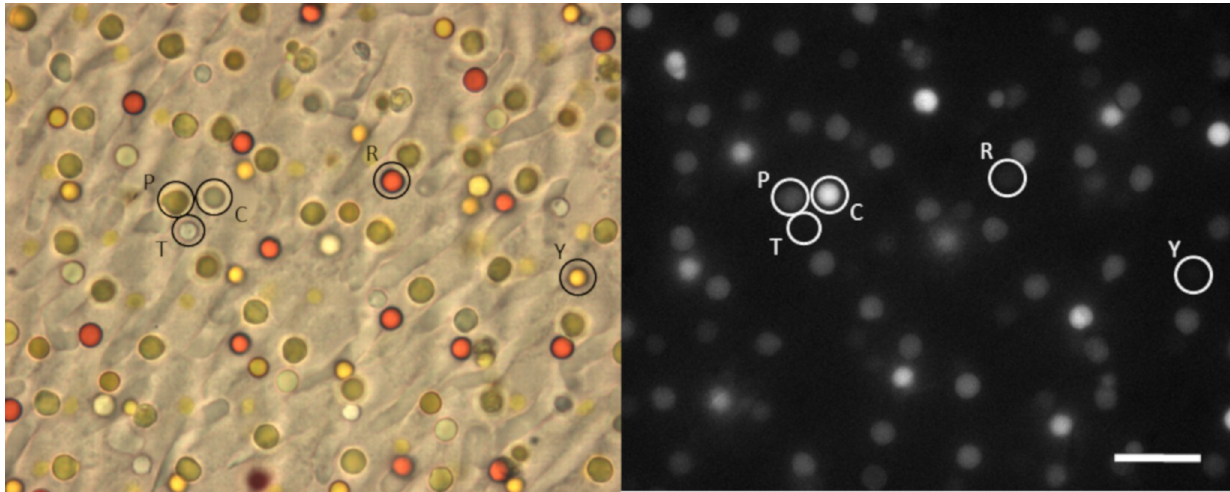
Fig 2. Light microscope images of the chicken retinas measured in this study. Samples were viewed under visible and UV illumination (left, right respectively). Examples of each droplet type are indicated (P—pale, R—red, Y—yellow, C–clear, T–transparent; scale bar = 10 μ m).